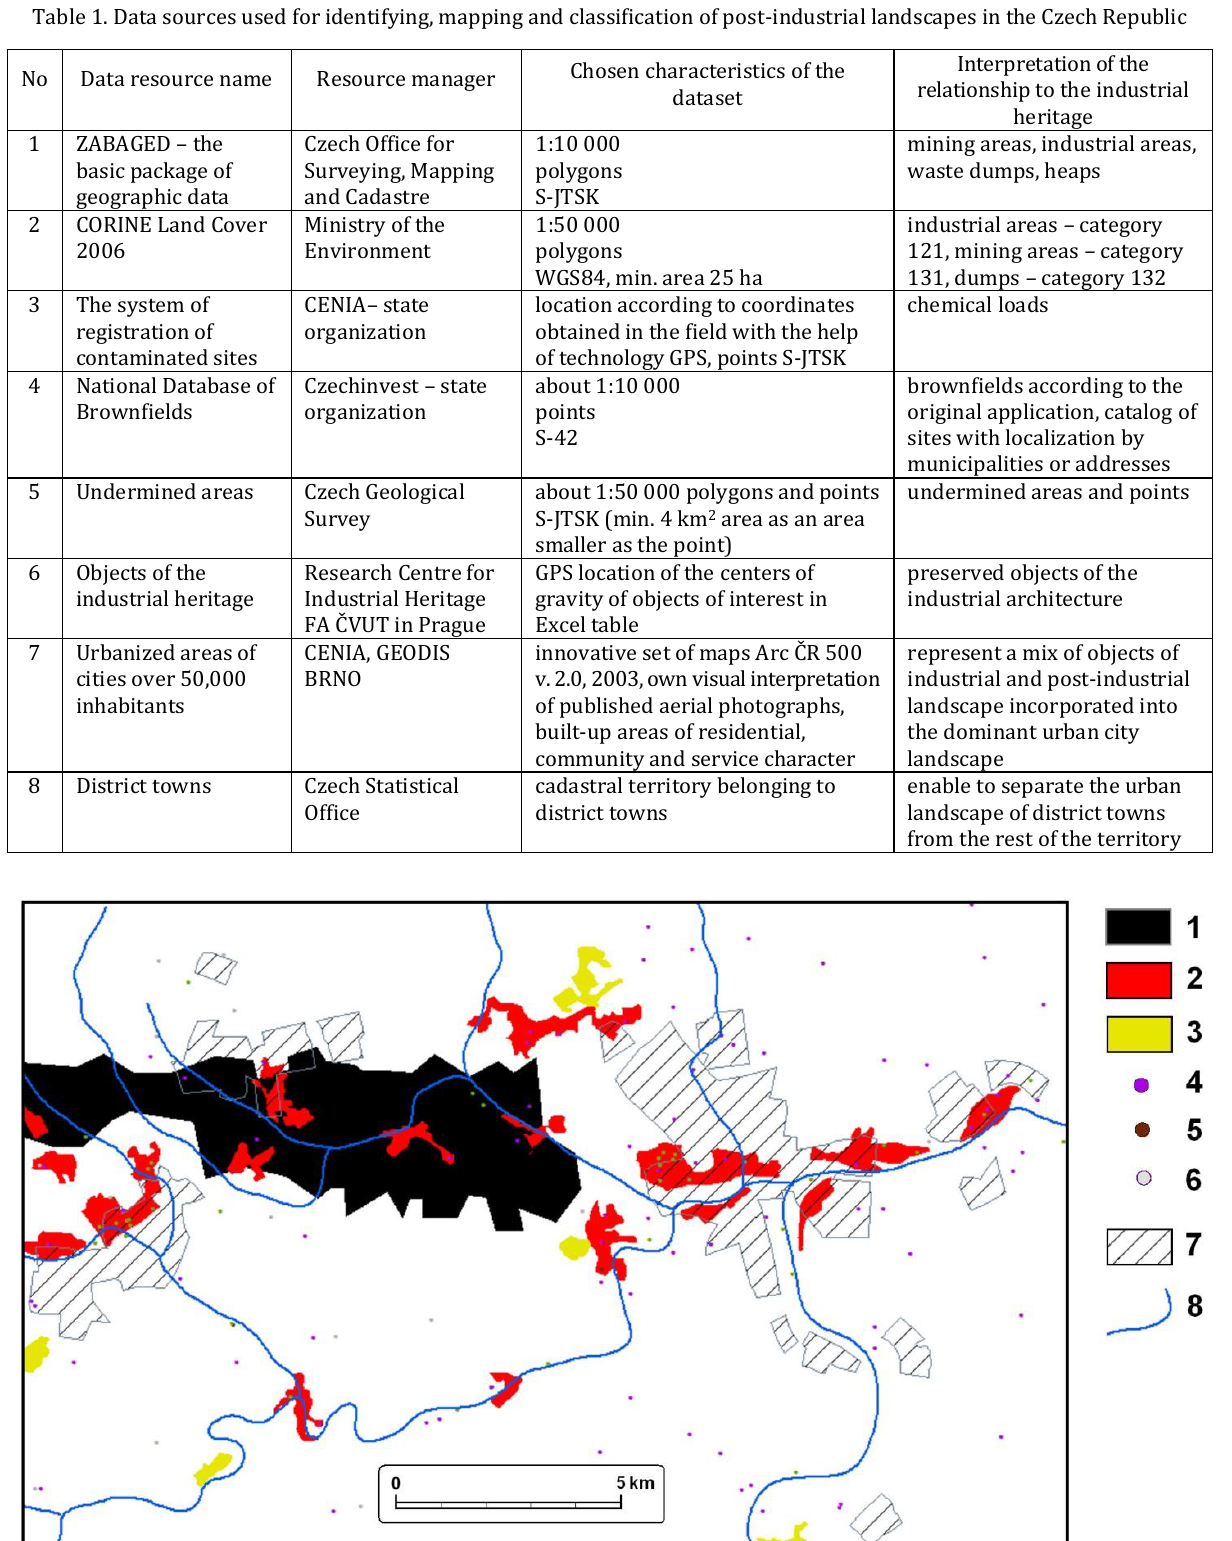
Fig. 2. Comprehensive cartographic representation of the relevant data from available databases appropriate to indicate the post-industrial